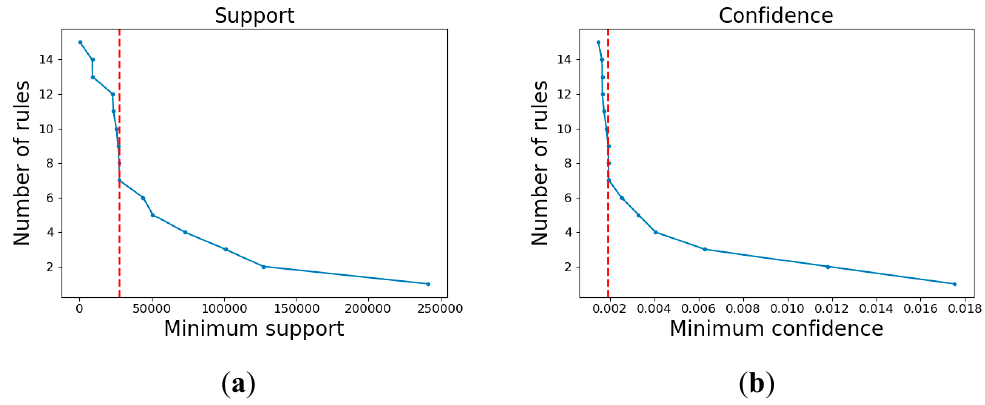
Figure 3. The number of association rules corresponding to different ( a ) minimum support (min_sup) and ( b )minimum confident (min_conf).